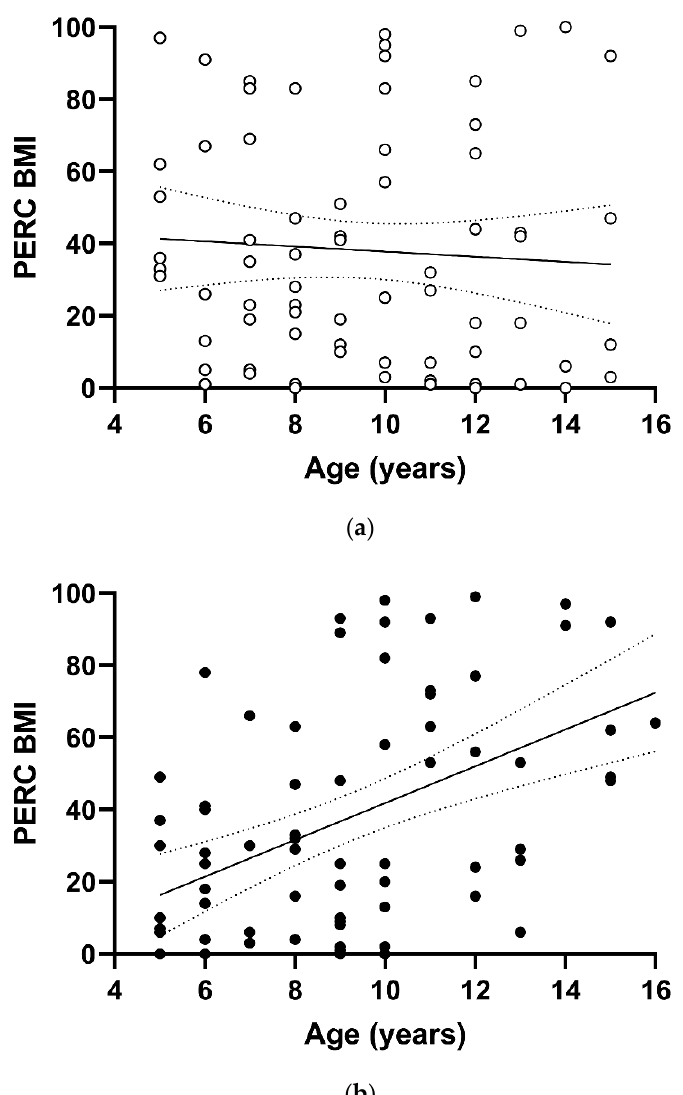
Figure 1. Scatterplot of PERC BMI versus age in groups defined by gender: ( a ) male; ( b ) female. During the collection of the anthropometric data, we also evaluated the blood pressure of the enrolled subjects. Elevated BP was detected in 15.18% of the population, 8.33% and 6.85% of the male and female population, respectively (Table 1). Among the variables, only the SBP z -score was significantly different according to the gender (46.66 ± 24.77 in males vs. 36.82 ± 25.34 in females, p = 0.022). The distribution of the maximum value between SBP z -score and DBP z -score did not change as a function of BMI z -score either in males or in females. To analyze the eating habits of the pediatric population of the study, we asked the parents to fill in a questionnaire, obtaining a response from 134 parents (93.7%). The results are summarized in Tables 2 and